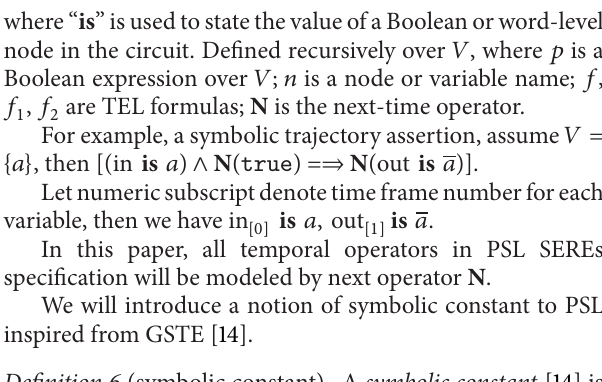
Figure 2: Algebraization steps of